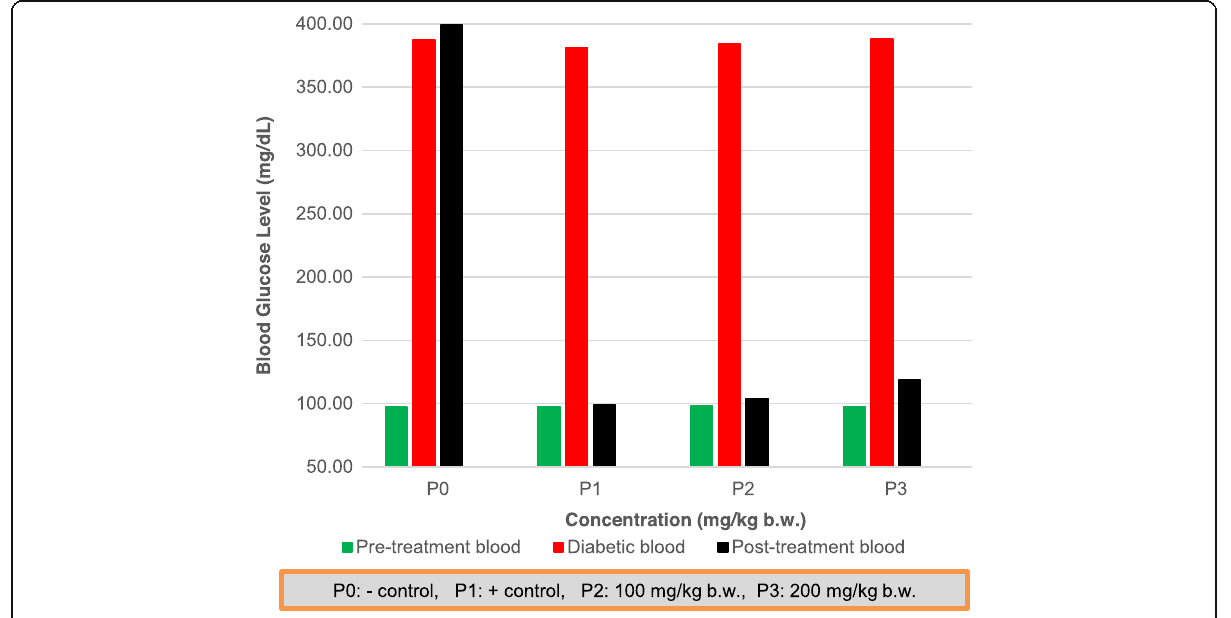
Fig. 2 Diagram of the treatment relationship of each group with blood glucose